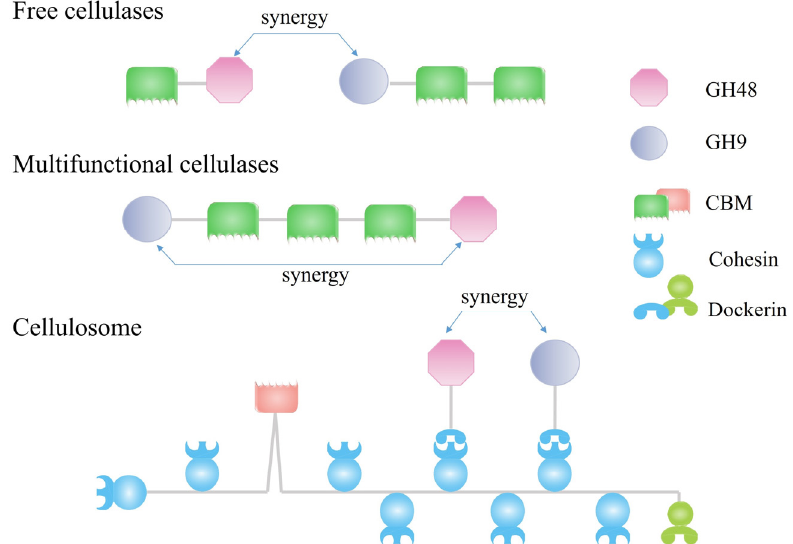
Figure 4. The three types of synergistic systems between GH48 cellulases and endocellulases. The figure was prepared in Microsoft PowerPoint.